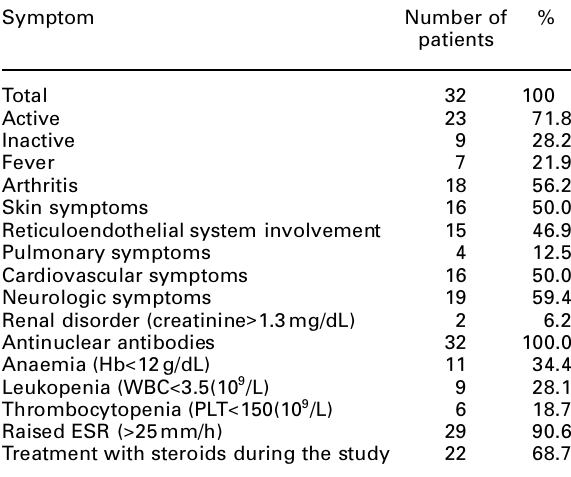
Table 1. Clinical and laboratory characteristics of the patient with SLE (symptoms according to Liang et al . 25